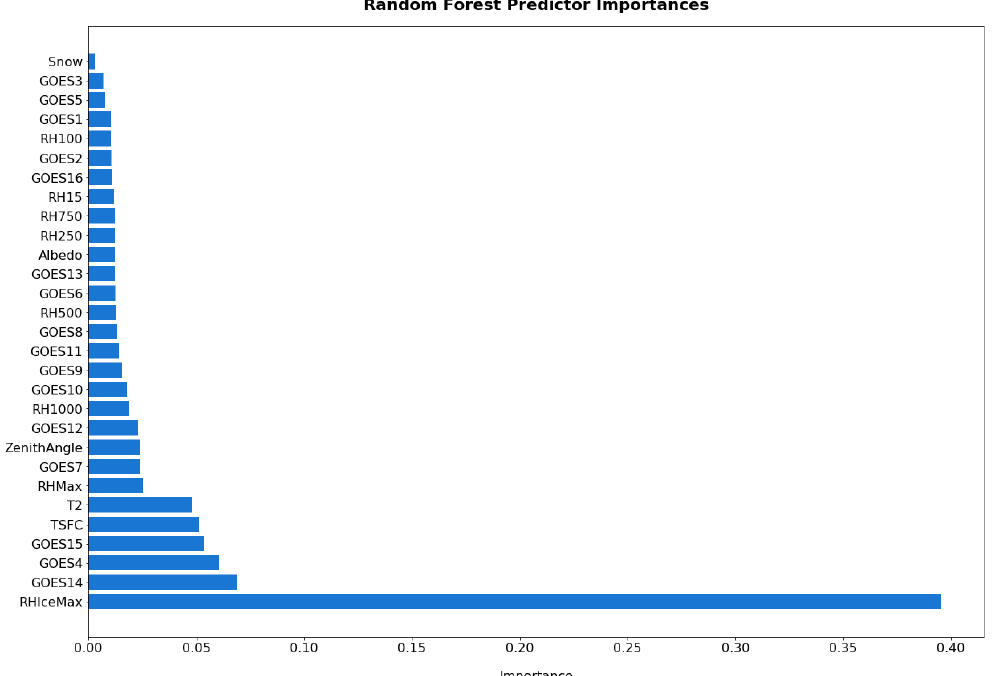
Figure 4. RF predictor importances, which highlight that the maximum relative humidity of the ice cloud layers (RHIceMax) is the most important predictor followed by the GOES channel 14.